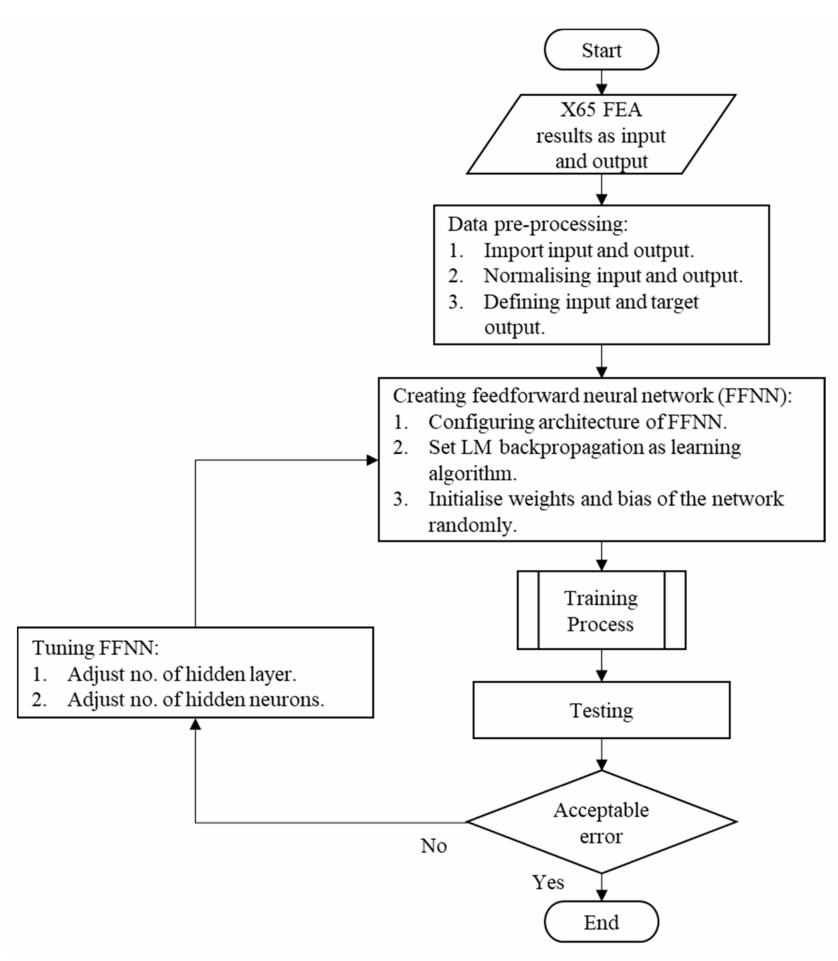
Figure 5. ANN framework.